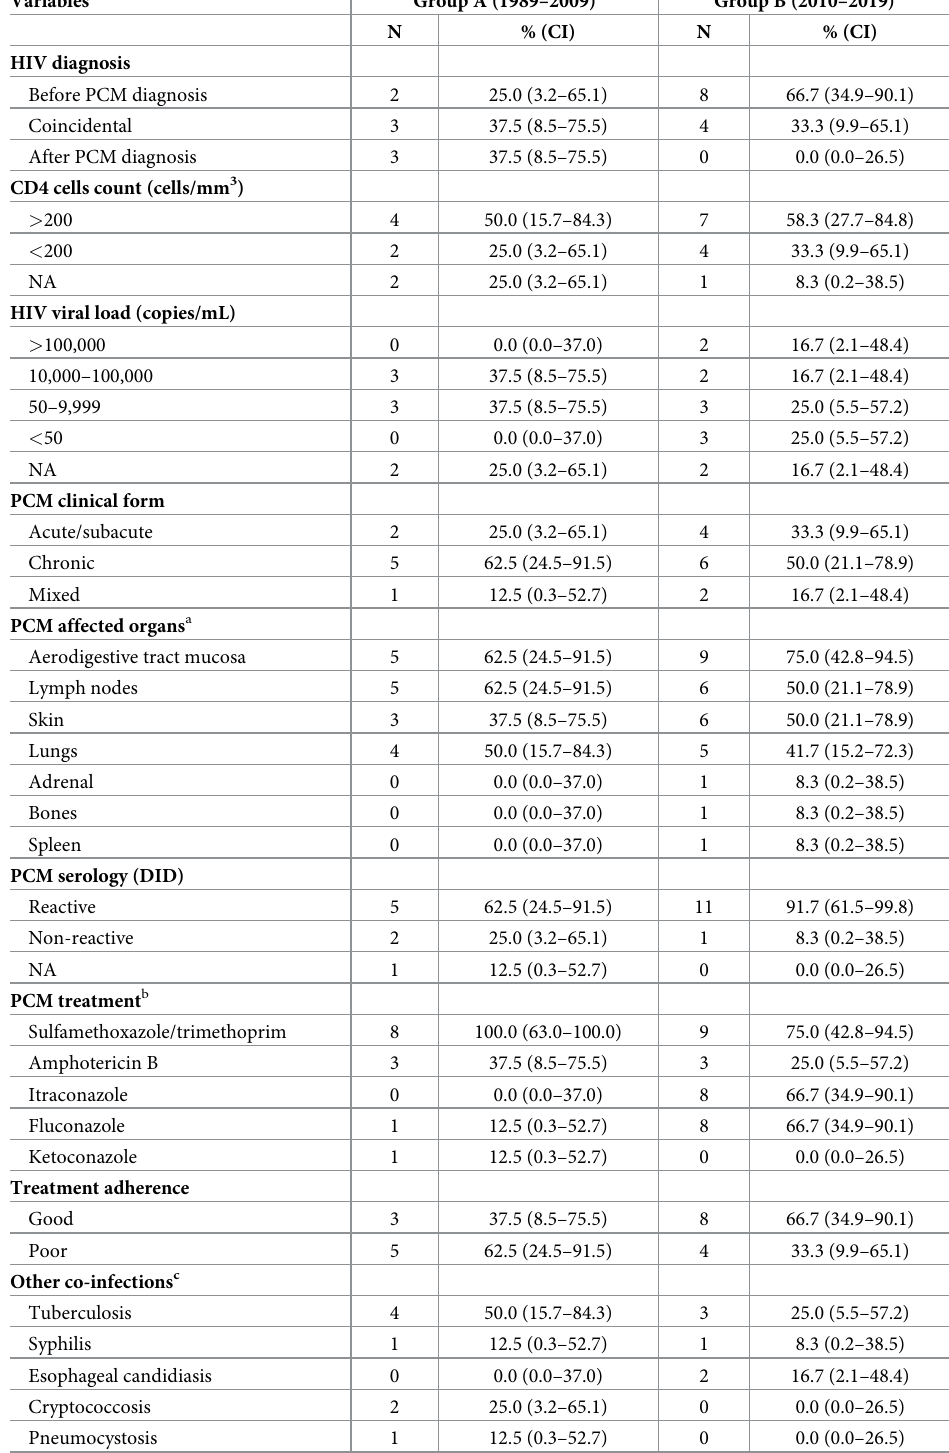
Table 2. Data of the HIV and PCM infection from the cases analyzed in this